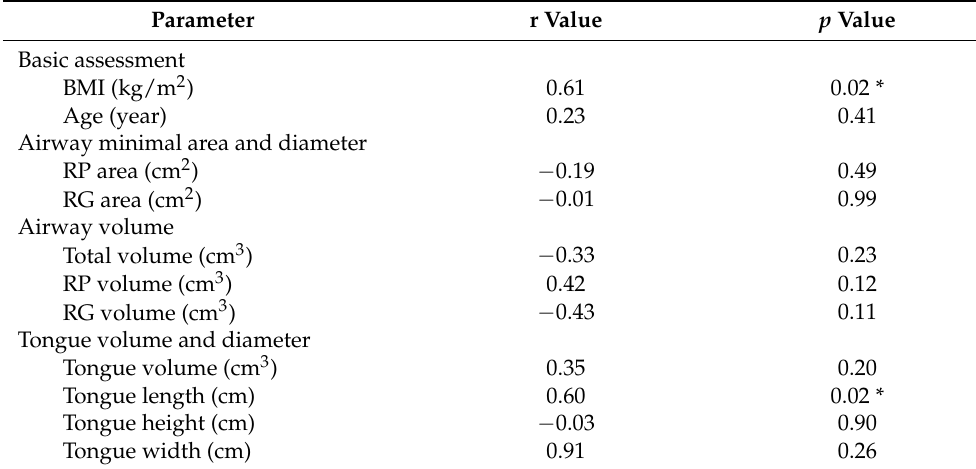
Table 1. Spearman correlation to baseline AHI.